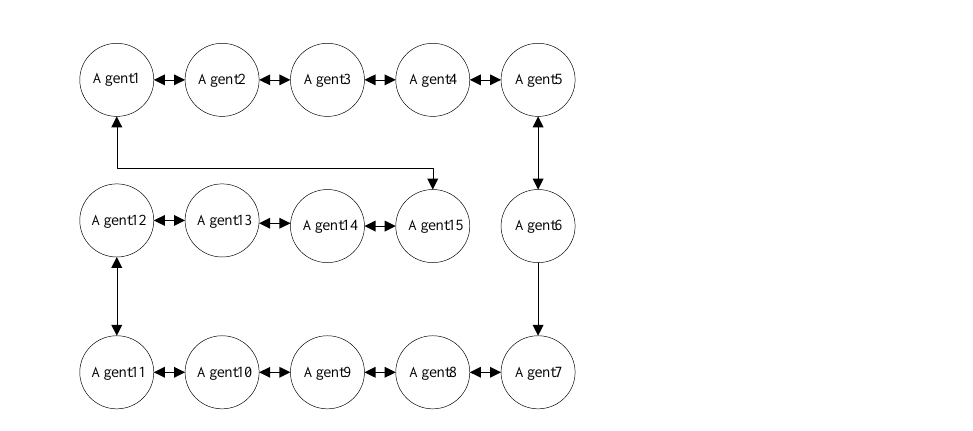
Figure 2. Upper Layer Communication Network, where 15 agents represent the 15 PV inverters in Figure 1.